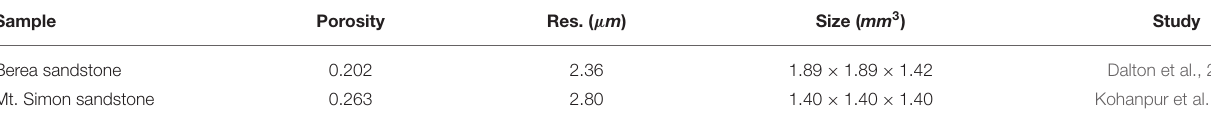
TABLE 4 | Selected samples for pore-network modeling of CO 2 -brine flow after a drainage-imbibition cycle.